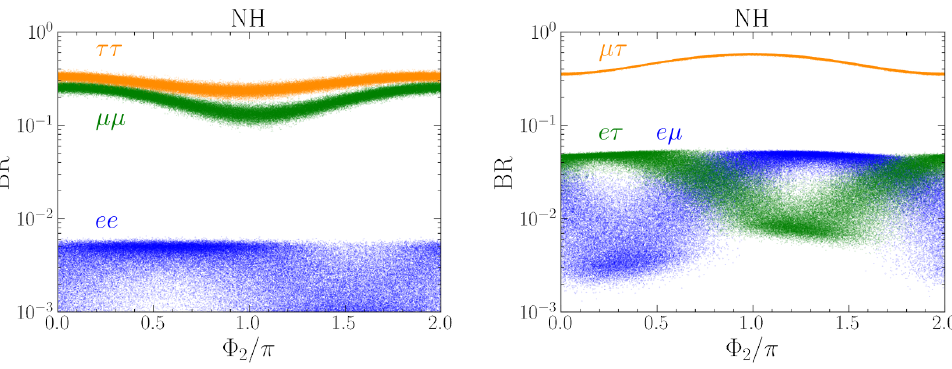
Figure 3 . Scatter plots for the same flavor (left) and different flavor (right) leptonic branching ratios for the H ++ decay versus Majorana phase Φ Majorana phase Φ is uniformly sampled within [0 , 2 π ) . 1